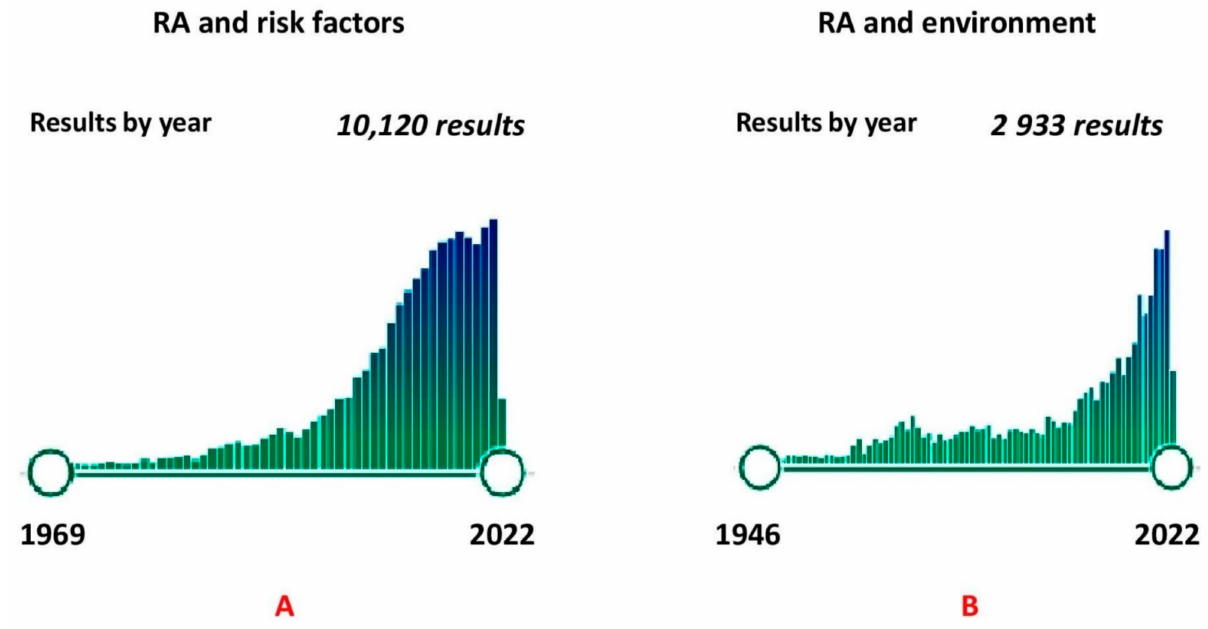
Figure 1. Results of PubMed publications searching with keywords ( A ) “RheumatoidArthritis and risk factors” (10,120 results in 1969–2022), ( B ) “Rheumatoid arthritis andenvironment” (2933 results in